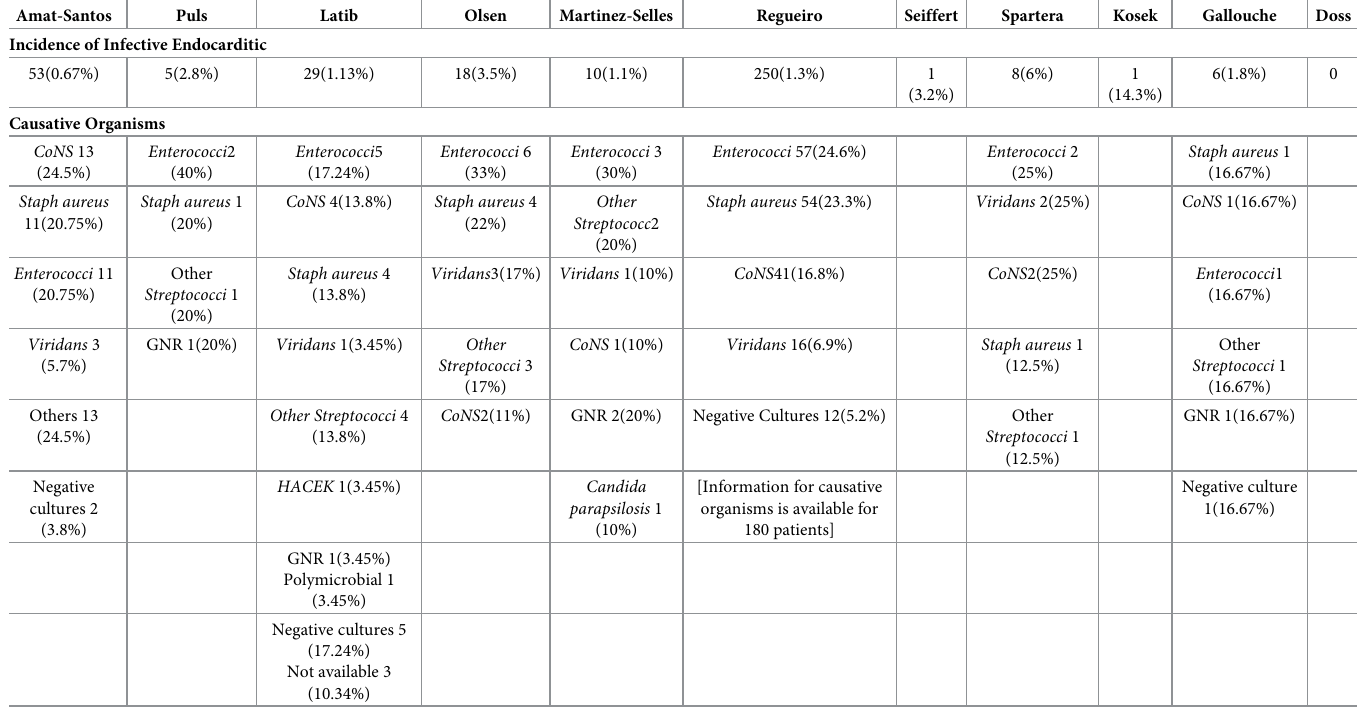
Fig 4. Percentage of post-TAVI infective endocarditis in studies included in the systematic review. The microbiological profile of post-TAVI infective endocarditis is reported in 8 studies. Enterococci are the most common causative organism isolated from 25.9% of cases followed by Staphylococcus aureus (16.1%), coagulase-negative Staphylococcus species (14.7%), other Streptococcus species (12.5%), Viridans streptococci (8.5%), gram negative rods/ HACEK / candida species (11%) and polymicrobial (0.42%).The cultures were negative in 6.7% of cases. The causative organisms of infective endocarditis are shown in Fig 5. https://doi.org/10.1371/journal.pone.0225077.g004 Table 4. Incidence of post-TAVI infective endocarditis in the included studies with its causative